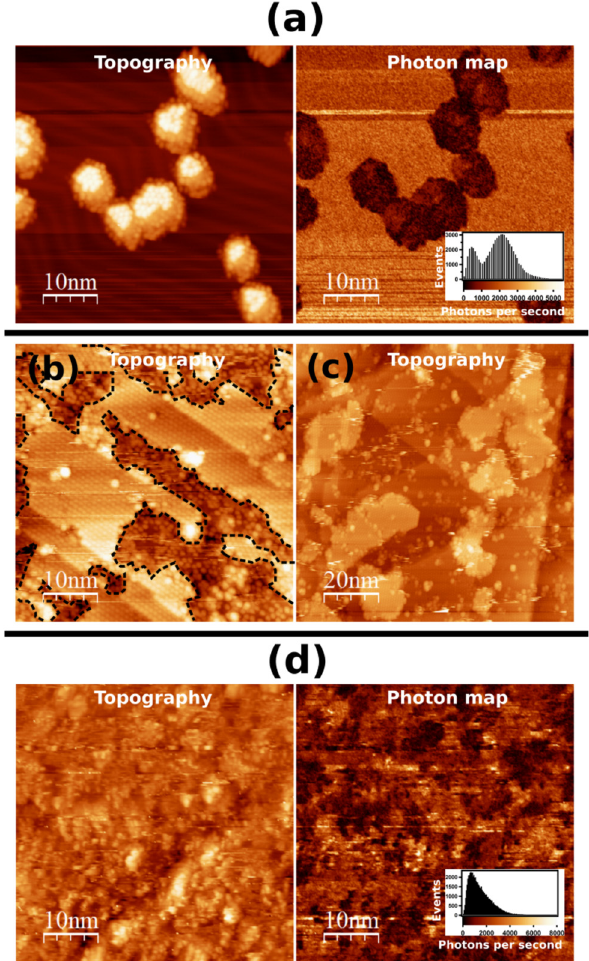
Figure 3. ( a ) STM topographic image and simultaneously acquired photon integration map of C 60 islands grown on Au(111) surface ( − 3.5 V, 500 pA, 256 × 256 pixels, 9.8 ms/pixel). ( b ) STM topographic image of (M)-[7]TH-diol molecules deposited on Au(111) surface partially covered with C 60 islands (1.0 V, 50 pA). C 60 islands are surrounded by the dotted lines. ( c ) STM topography image of (M)-[7]TH-diol molecules at a low coverage deposited on fully covered C 60 layer grown on Au(111) surface ( − 2.5 V, 50 pA). ( d ) STM image ( − 3.0 V, 800 pA, 256 × 256 pixels, 15.6 ms/pixel) and simultaneously acquired photon integration map of multilayer of (M)-[7]TH-diol adsorbed on fully covered C 60 layer grown on Au(111) surface.